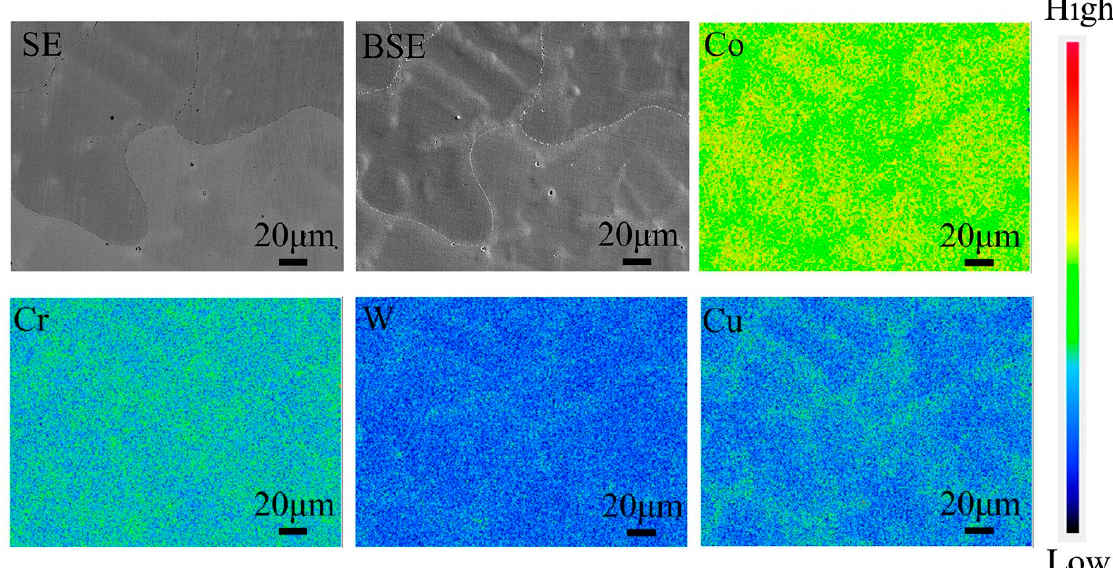
Figure 2. SEM images and corresponding EPMA elemental maps of the CoCrW-4Cu alloy at low mag- nification. (SE: Secondary electron; BSE: Backscattered electron)